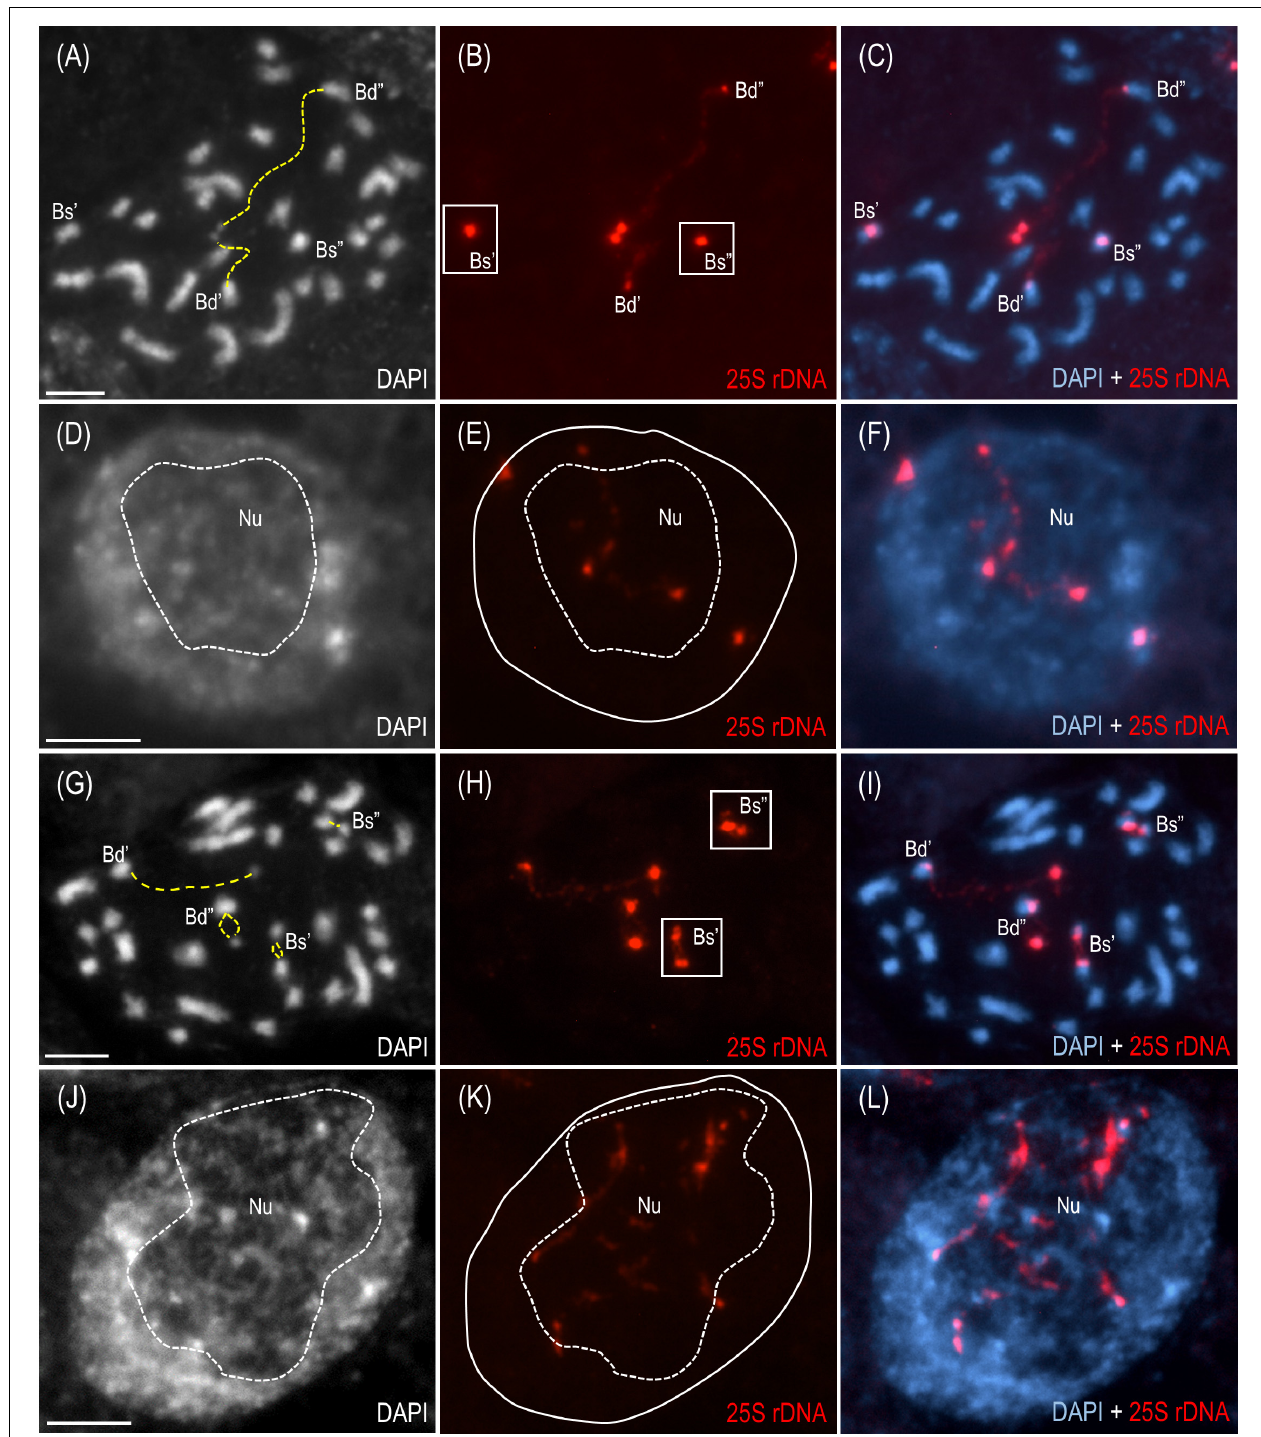
FIGURE 2 | The distribution of the 35S rDNA loci in the mitotic metaphase chromosomes and interphase nuclei of B. hybridum genotype 3-7-2. The cells originating from the primary (A–F) and adventitious (G–L) root apical meristems are presented.. FISH mapping of 25S rDNA (red fluorescence) in the metaphase chromosome complements (A–C,G–I) and interphase nuclei (D–F,J–L) . Bd, B. distachyon -inherited 35S rDNA loci; Bs, B. stacei -inherited 35S rDNA loci; Nu, nucleolus. The secondary constrictions on (A,G) are indicated by the yellow dashed lines. The position of the nucleolus on (E,K) is denoted by a white dashed line. Chromatin was stained with DAPI. Scale bar = 5 µ